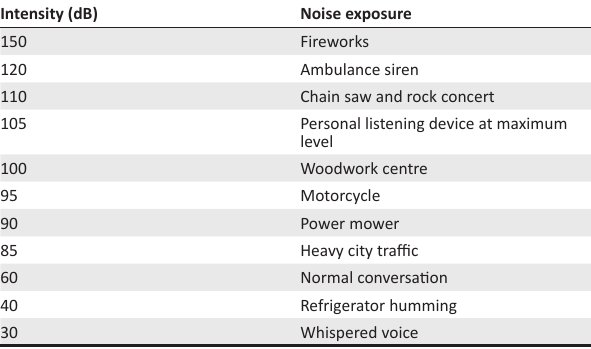
TABLE 1: What is too loud and how loud is too